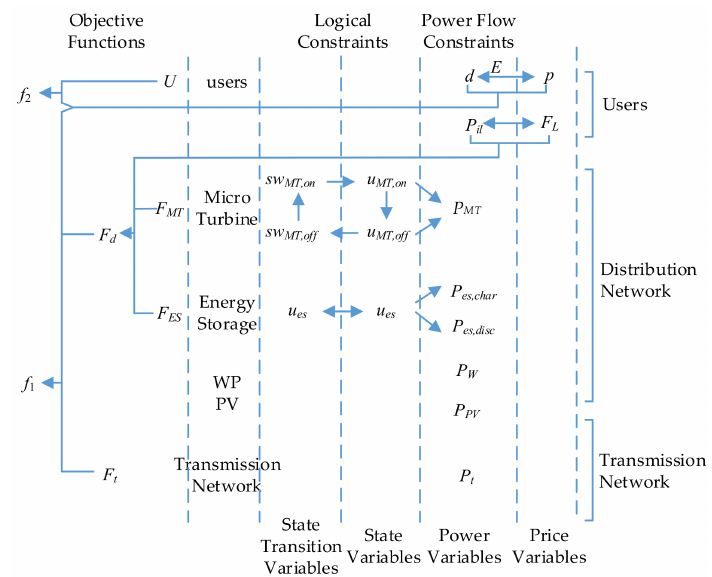
Figure 3. Logic composition diagram of optimal dispatch